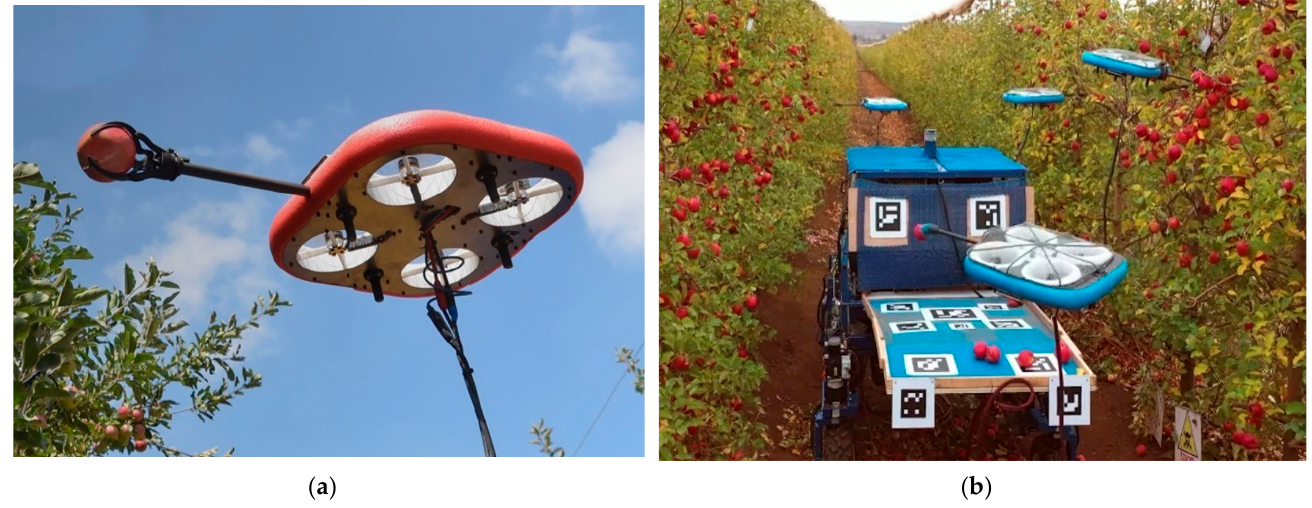
Figure 9. Telev aerial harvesting system: ( a) flying autonomous robot (FAV); ( b ) wheeled base vehicle and four FAVs [88]. Table 2. Aerial robotic manipulation systems for harvesting. Evaluation metrics of harvesting cycle time (time) and detachment success rate (accuracy) are included. Grasping from the stem is marked with “ ✓ s”; all other cases refer to direct contact grasping of the fruit. Detachment Manipulator End Effector Evaluation Method